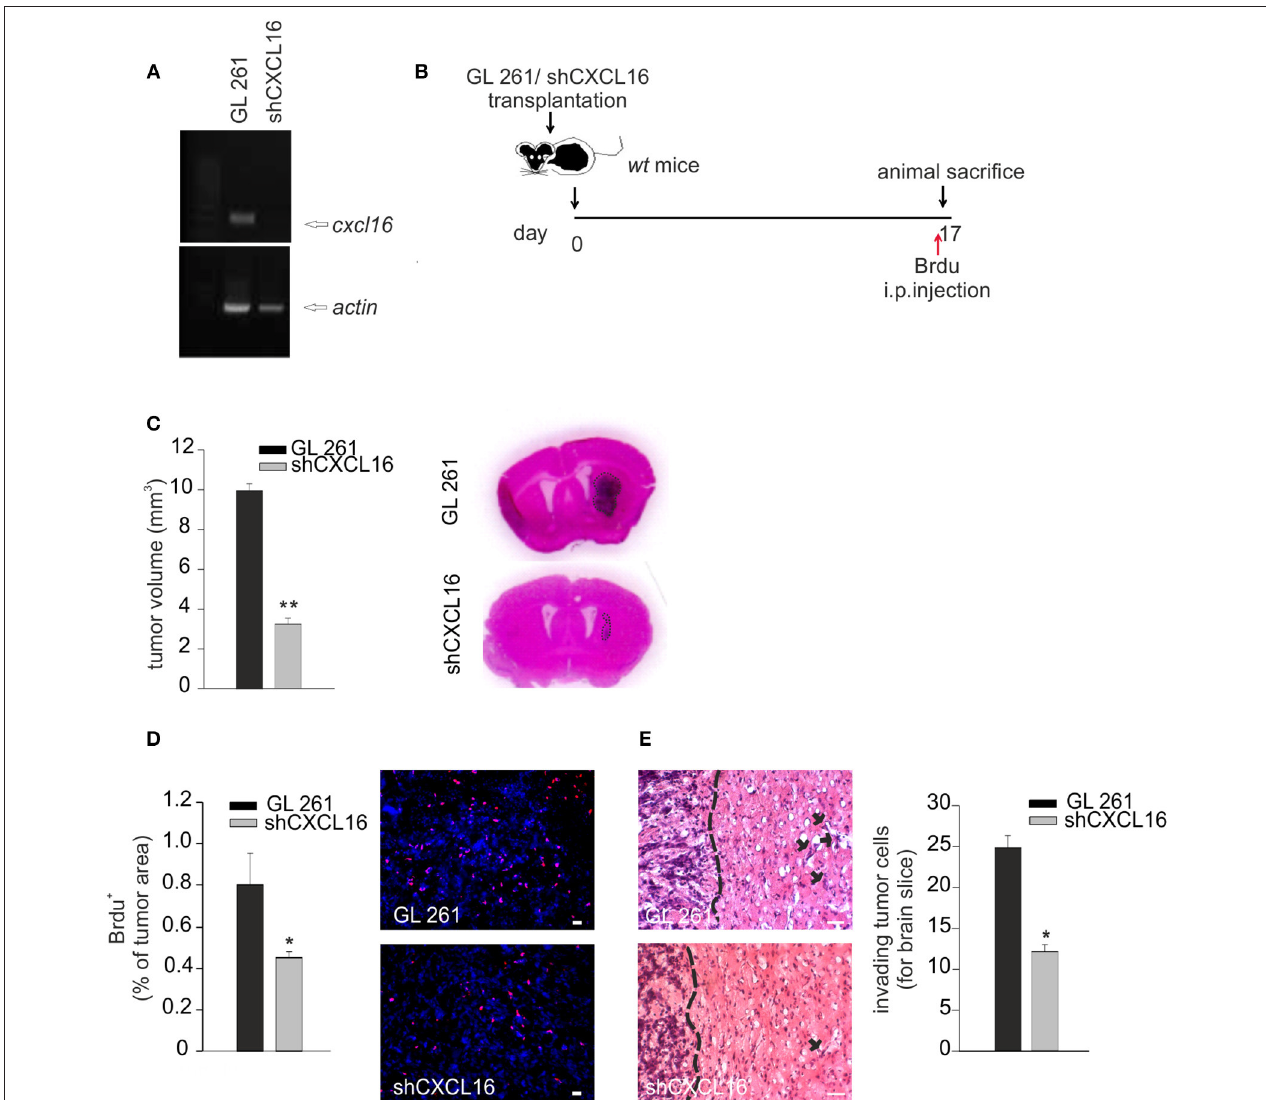
FIGURE 5 | CXCL16 released by glioma cells acts promoting tumor proliferation in vivo . (A) RT-PCR for cxcl16 and actin mRNAs expression in GL261 and shCXCL16 cells; (B) representative scheme of GL261 and shCXCL16 cells transplantation in wt mice; (C) bar histogram of tumor volume in GL261 or shCXCL16 cells bearing mice, and representative hematoxylin-eosin stained coronal brain sections; (D) BrdU proliferation analysis in mice bearing GL261 or shCXCL16 cells. Left panel, bar histograms of immunofluorescence analysis of BrdU + cells; data are expressed as % of BrdU + staining per tumor area; right panel, representative images (scale bar = 20 µ m) of proliferating BrdU + cells (red) within tumor area; (E) Analysis of glioma cells invasion of surrounding brain tissue in mice injected with GL261shCXCL16 or GL261. Representative coronal brain sections stained with hematoxylin/eosin. Black arrows indicate glioma cells invading the brain parenchyma beyond the main tumor border (dashed line) for more than 150 µ m. Right, bar histogram of the number of glioma invading cells. Statistical analysis: Data are expressed as the mean ( ± s.e.m.) (C,D) n = 4, * p < 0.05, ** p < 0.001, Student’s t -test; (E) n = 3, * p < 0.05, Student’s t -test.